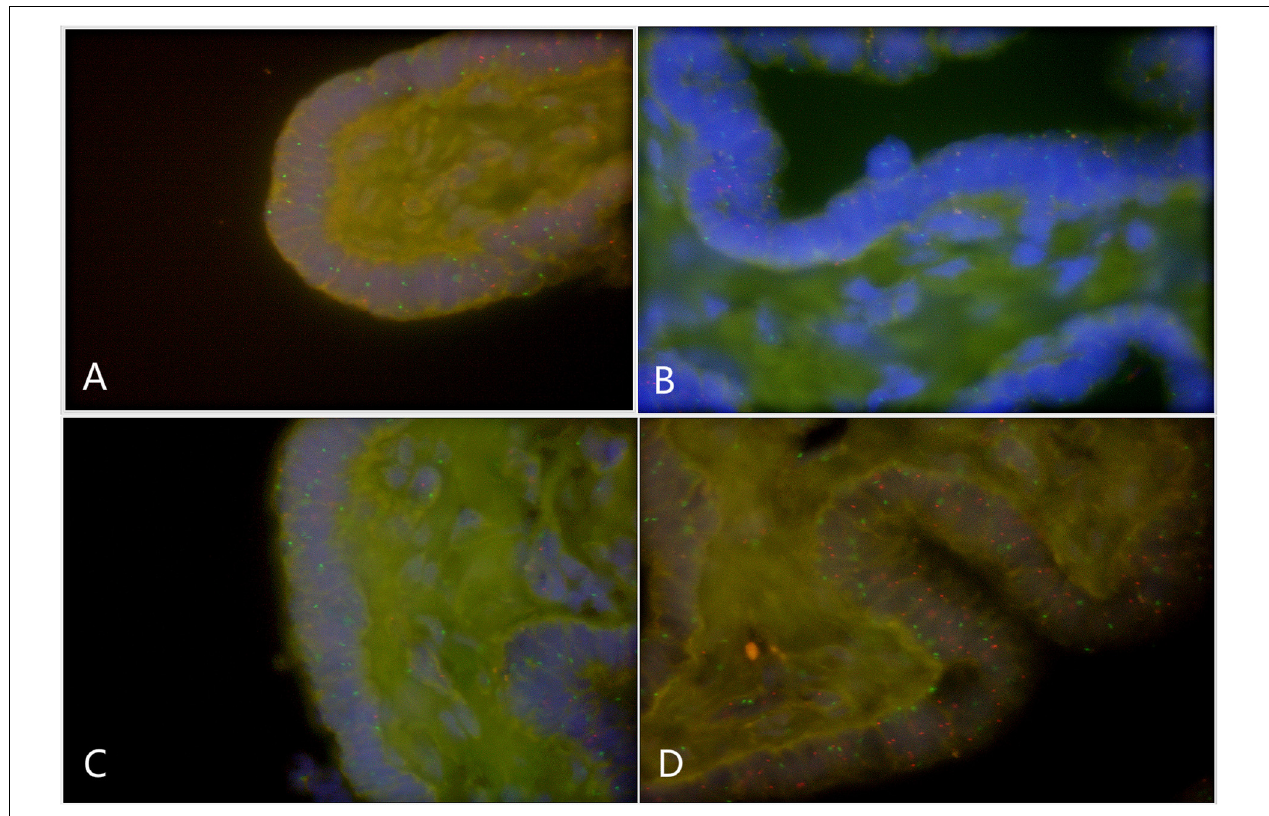
FIGURE 3 | Fluorescence in situ hybridization (FISH) on fallopian tubes tissue that originated from a DSD boy with XYY in blood (A66) (green spot: FISH centromeric signals of Chromosome X; red spot: signals of Chromosome Y). (A) X/XY signals; (B) X/XY signals; (C) X/XY signals; (D) XYY